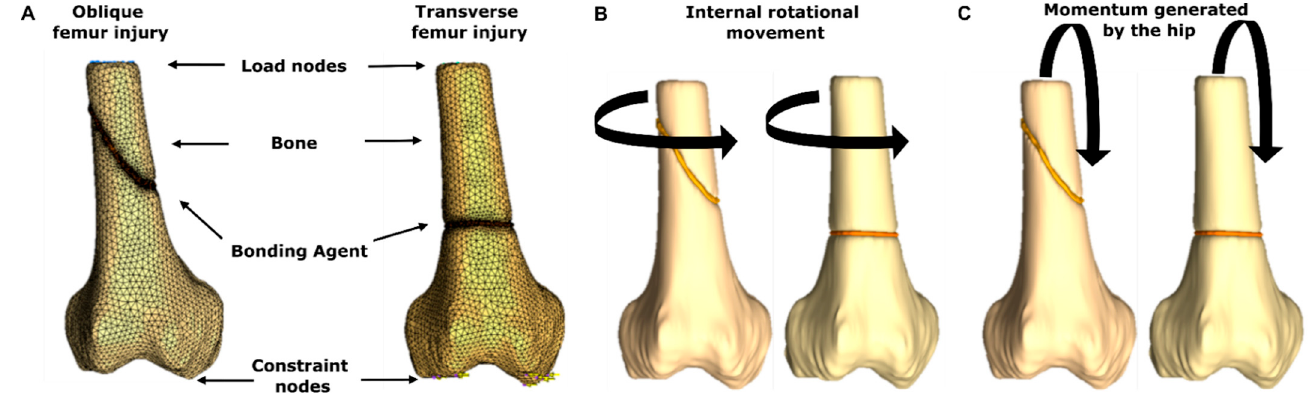
Figure 4. Geometries employed for the FEA simulations. ( A ) Components of the geometries along with the rendered mesh. ( B ) Load direction during internal rotation of the knee. ( C ) Load direction during hip momentum.